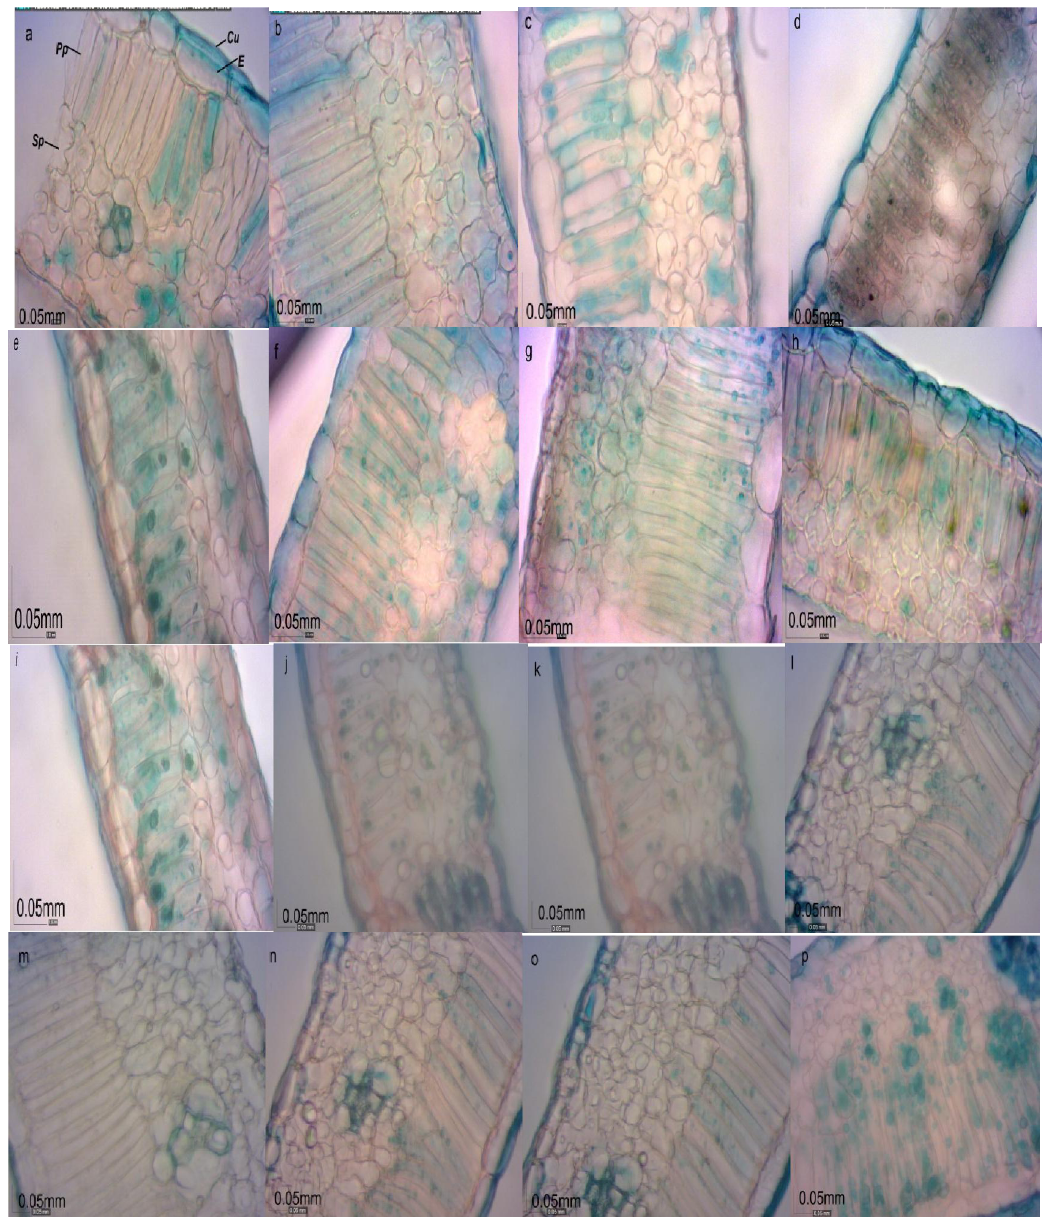
Fig. 2. Lamina cross sections in the populations of C. orientalis: a, Abshar; b, Gheji; c, Kanigandi; d, Kiasar (1000 m a.s.l); e,Kiasar (1400 m a.s.l); f, Rasht (1600m a.s.l); g, Rasht (1800 m a.s.l); h, Tangeh Gol; I, Tangrah; j, Qozlogh (1100 m a.s.l); k, Qozlogh (1300 m a.s.l); l, Zaringol; m, Mohammad Abad; n, Parand (904 m a.s.l); O, Parand (805 m a.s.l); P, Chelav; Cu – cuticle; E – epidermis; Pp – Palisade parenchyma; Sp – Spongy parenchyma